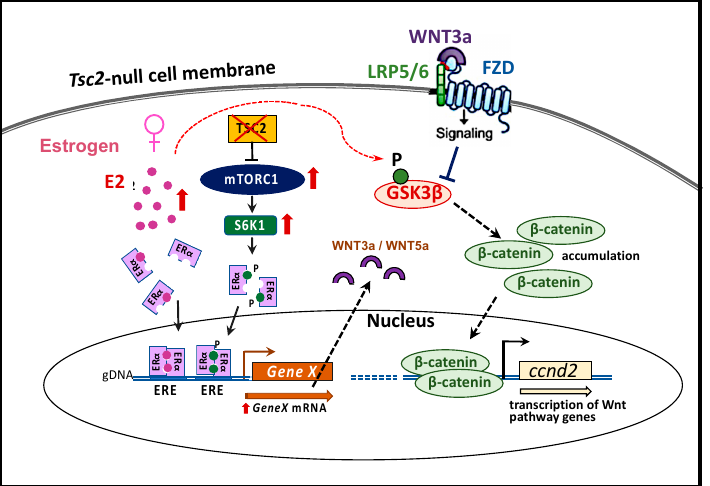
Figure 4. Cartoon of mTORC1, Wnt/ β -catenin, and estrogen receptor α (ER α ) molecular pathway interplay in the female-specific, Tsc2-null, rare lung disease lymphangioleiomyomatosis (LAM). Estrogen activates ER α nuclear localization and dimerization. In the absence of Tsc2 suppressor function, mTORC1 activates S6K phosphorylation, which, in turn, phosphorylates and activates ER α . Estrogen-stimulated genes, such as the Wnt ligands Wnt3a/5a, are transcribed and can in an autocrine manner activate frizzled (FZD) and LRP5/6 Wnt receptors. S6K also phosphorylates GSK3 β , resulting in deactivation of the β -catenin destruction complex. β -catenin translocates to the nucleus, enhancing transcription of Wnt/ β -catenin specific genes, such as cyclin D2 (ccnd2).